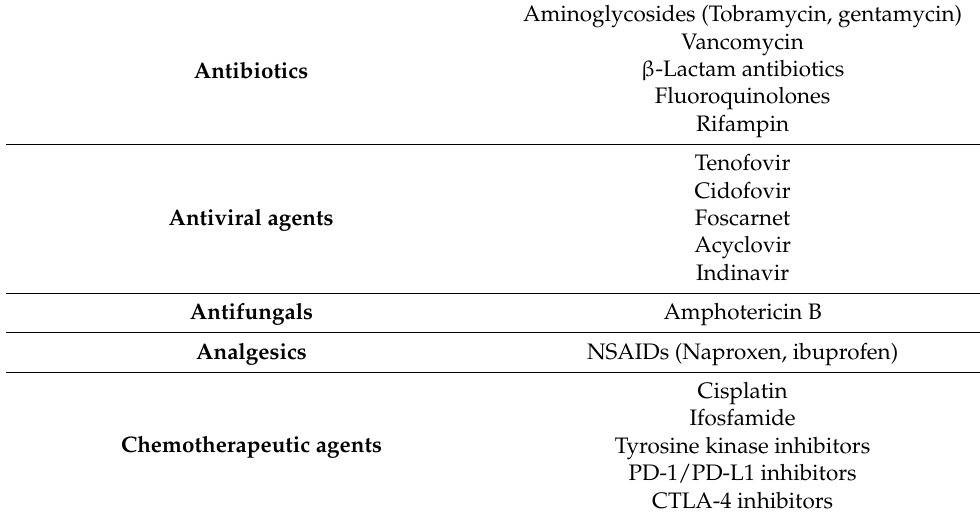
Table 2. Medications associated with